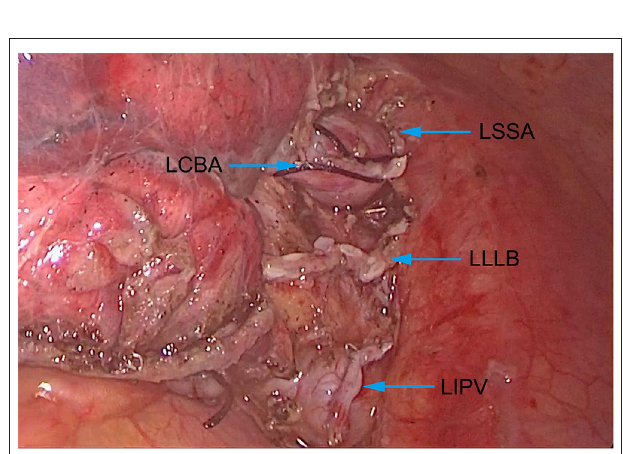
infancy, following investigation of severe respiratory